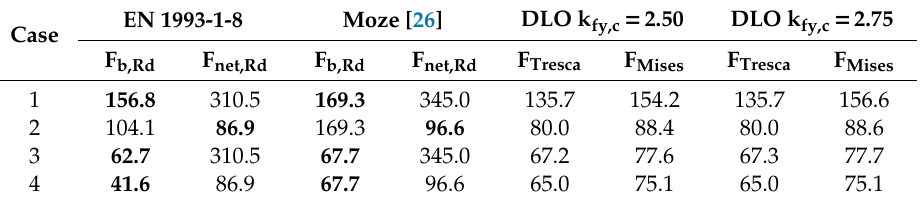
Table 4. Comparison of the ultimate loads in kN for the considered